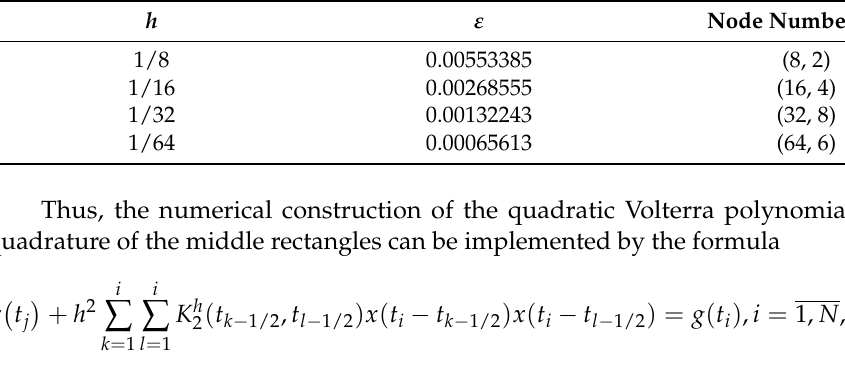
Table 1. The error of the numerical solution to (17) with the right side (29).